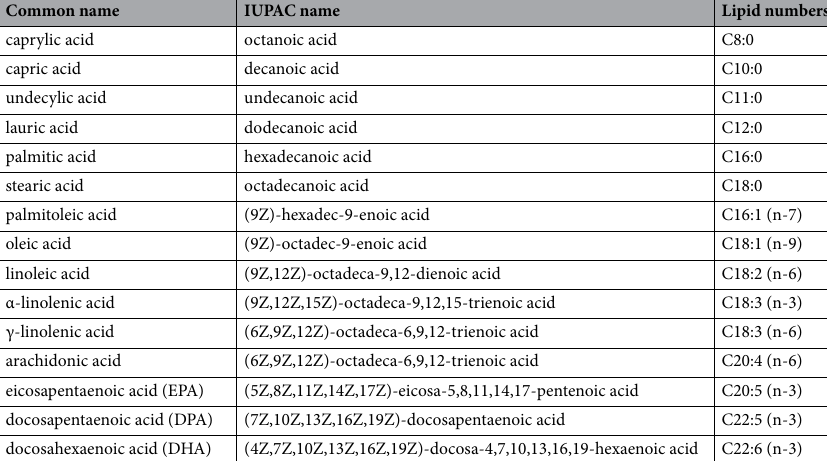
Table 1. List of selected dietary fatty acids used in this